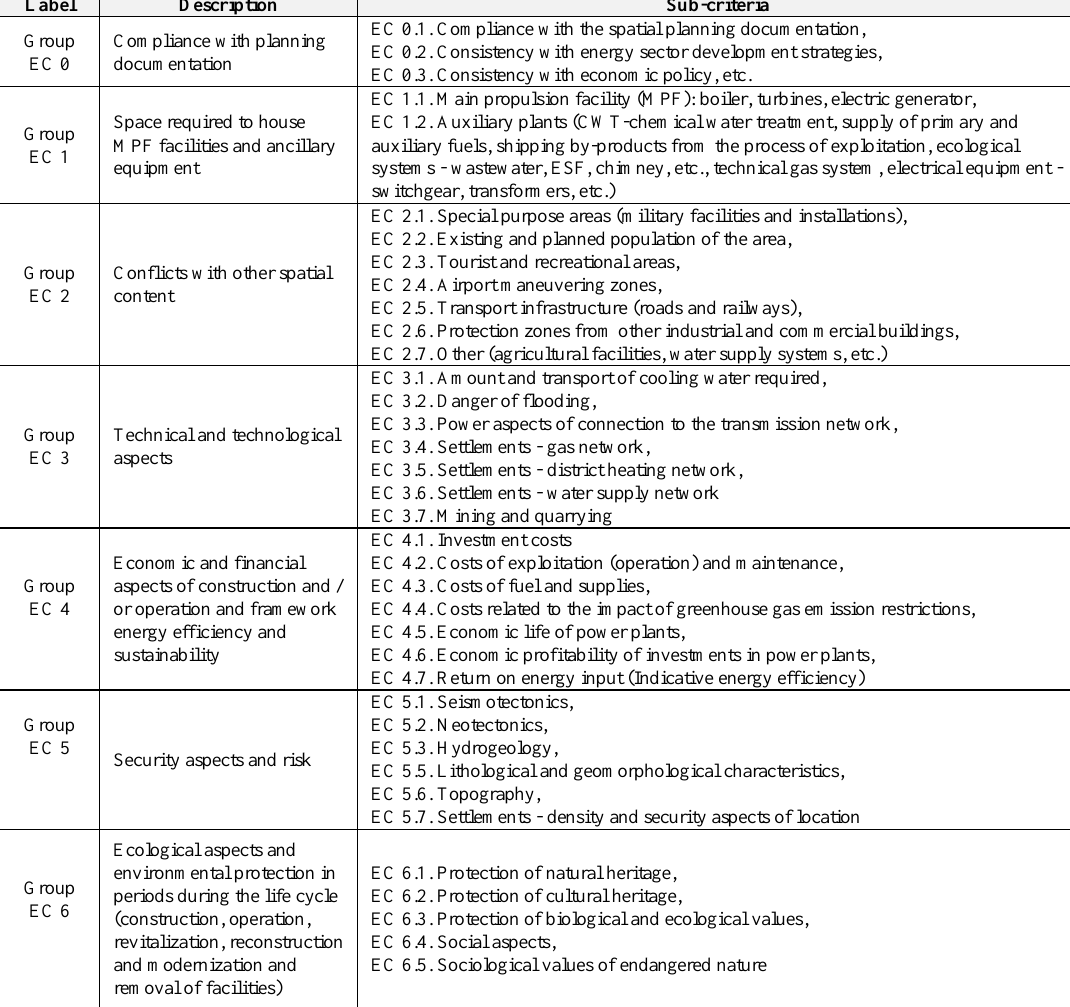
Table 1. Overview of the elimination criteria for the selection of coal / gas / fuel oil TPP